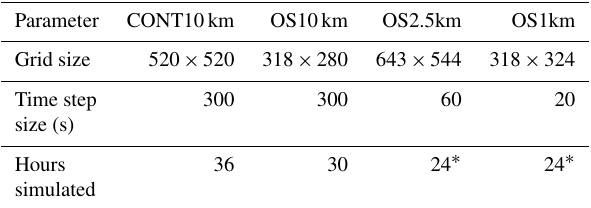
Table 1. Nested domain